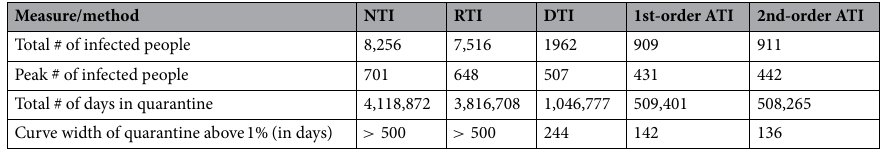
Table 2. Performance evaluation for a 70% quarantine success